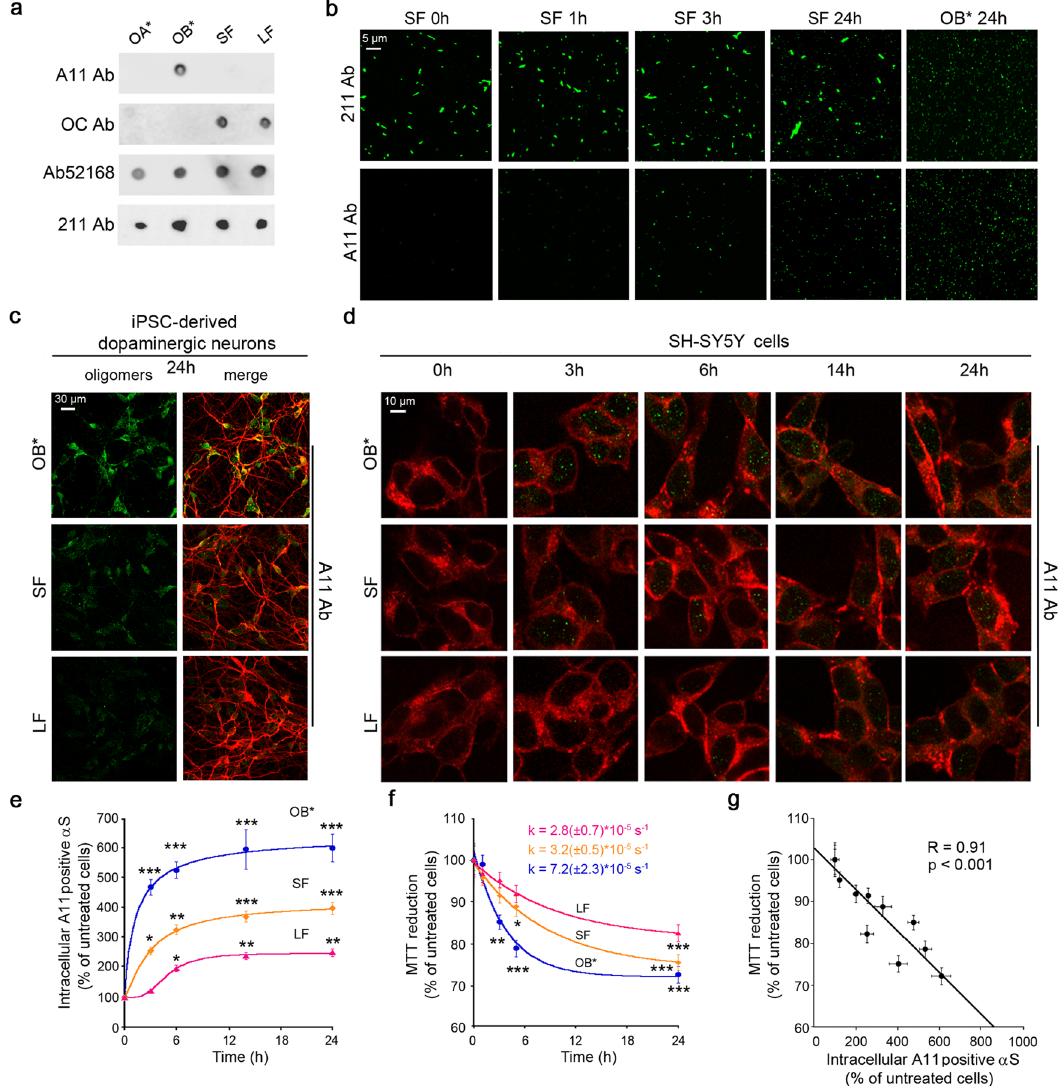
Fig. 4 α S fi brils gradually release oligomers that are ultimately responsible for their toxicity. a Dot-blot analysis of α S species probed with conformational speci fi c antibody A11 (AHB0052, Thermo Fisher Scienti fi c), OC (AB2286, Sigma-Aldrich), conformation-insensitive polyclonal anti- α S antibody (ab52168, Abcam) and conformation-insensitive monoclonal 211 antibody speci fi c for human α S (sc12767, Santa Cruz Biotechnology). b Representative confocal microscope images showing SF (at 0.3 μ M) incubated in CM without cells in wells containing a glass coverslip for 0 – 24 h at 37 °C. Representative images of OB* incubated for 24 h were also shown as positive control. The green- fl uorescent signals derive from the staining with mouse monoclonal 211 anti- α S antibodies and rabbit anti-oligomer A11 polyclonal antibodies, in the fi rst and second rows, respectively, and then Alexa- Fluor 514-conjugated anti-mouse or anti-rabbit secondary antibodies (three independent experiments with one internal replicate). c Representative confocal scanning microscope images showing human iPSC-derived dopaminergic neurons treated for 24 h with OB*/SF/LF at 0.3 µ M. Red and green fl uorescence indicates mouse anti-MAP-2 antibodies (ab11267, Abcam) and the A11-positive pre fi brillar oligomers, respectively. d Representative confocal scanning microscope images showing the median sections of SH-SY5Y cells treated for the lengths of time indicated with OB*/SF/LF at 0.3 µ M. Red and green fl uorescence indicates the cell membranes labeled with WGA and the A11-positive pre fi brillar oligomers, respectively (three independent experiments with four internal replicates). e Kinetic plots reporting A11-intracellular fl uorescence following the addition of 0.3 μ M of the indicated α S species to SH-SY5Y cells. The continuous lines through the data represent the best fi ts to exponential and sigmoidal functions (see “ Methods ” ), for OB*, SF, and LF, respectively. f Kinetic plots reporting the MTT reduction versus time elapsed following addition of 0.3 μ M of the indicated α S species to SH- SY5Y cells. g Dependence of MTT reduction on the penetration of A11-positive α S in SH-SY5Y cells treated with α S species. MTT reduction values reported in ( f ) plotted against the α S-derived intracellular fl uorescence values reported in ( e ) of cells treated with OB*/SF/LF at the corresponding times. Experimental errors are S.E.M. ( n = 3 with four internal replicates in panel ( e ); n = 4 with three internal replicates in panel ( f ); n = 3 with four internal replicates and n = 4 with three internal replicates for MTT reduction and intracellular A11-positive aS, respectively, in panel ( g ). Samples were analyzed by one-way ANOVA followed by Bonferroni ’ s multiple comparison test relative to untreated cells (in panels e and f , * P < 0.05, ** P < 0.01, *** P < 0.001; in panel g , P < 0.001). A total of 200 – 250 cells ( e ) and 150,000 – 200,000 cells ( f ) were analyzed per